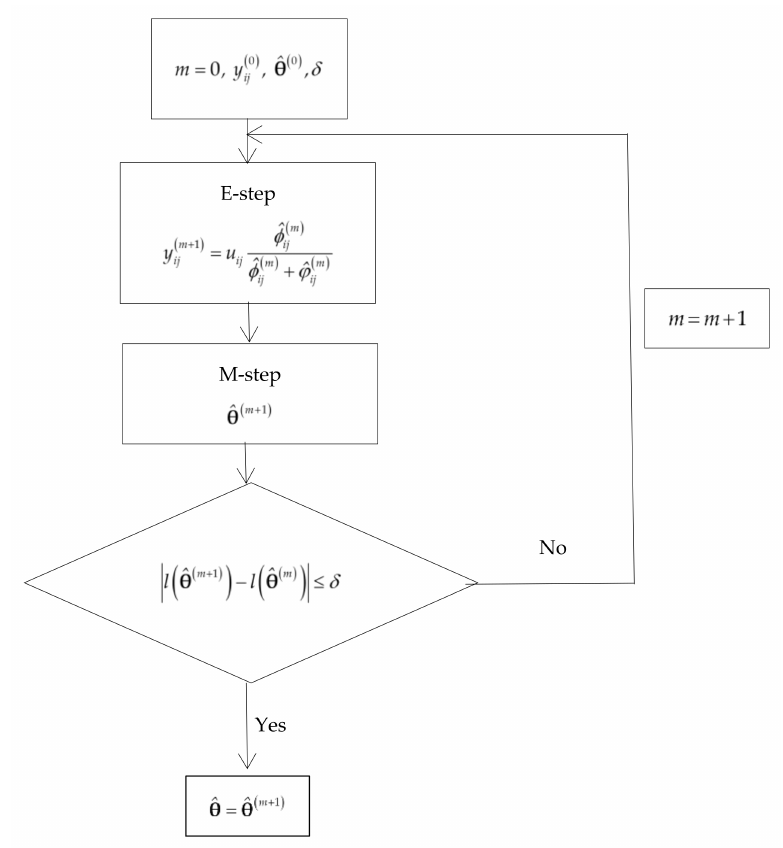
Figure 1. Flowchart of the EM